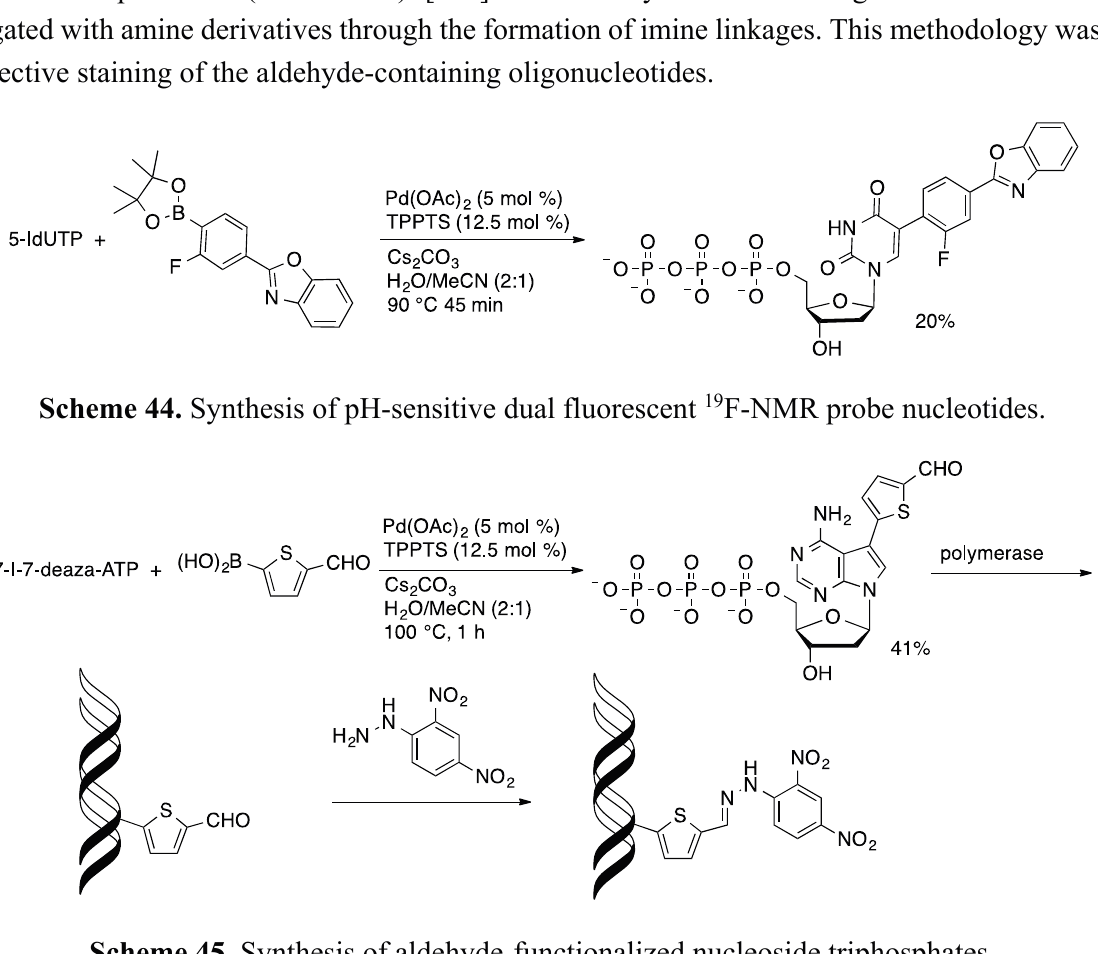
Scheme 45. Synthesis of aldehyde-functionalized nucleoside